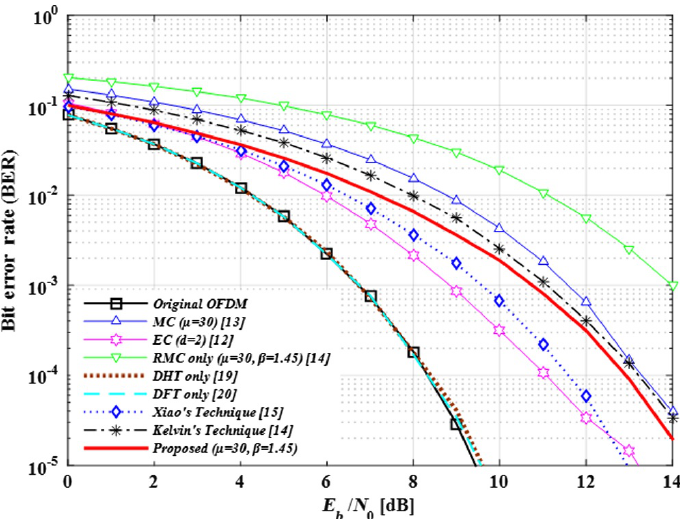
Fig. 9 Comparison of the bit error rate of the original algorithm PAPR after increasing the limit threshold in the case of FRFT. FRFT, fractional Fourier